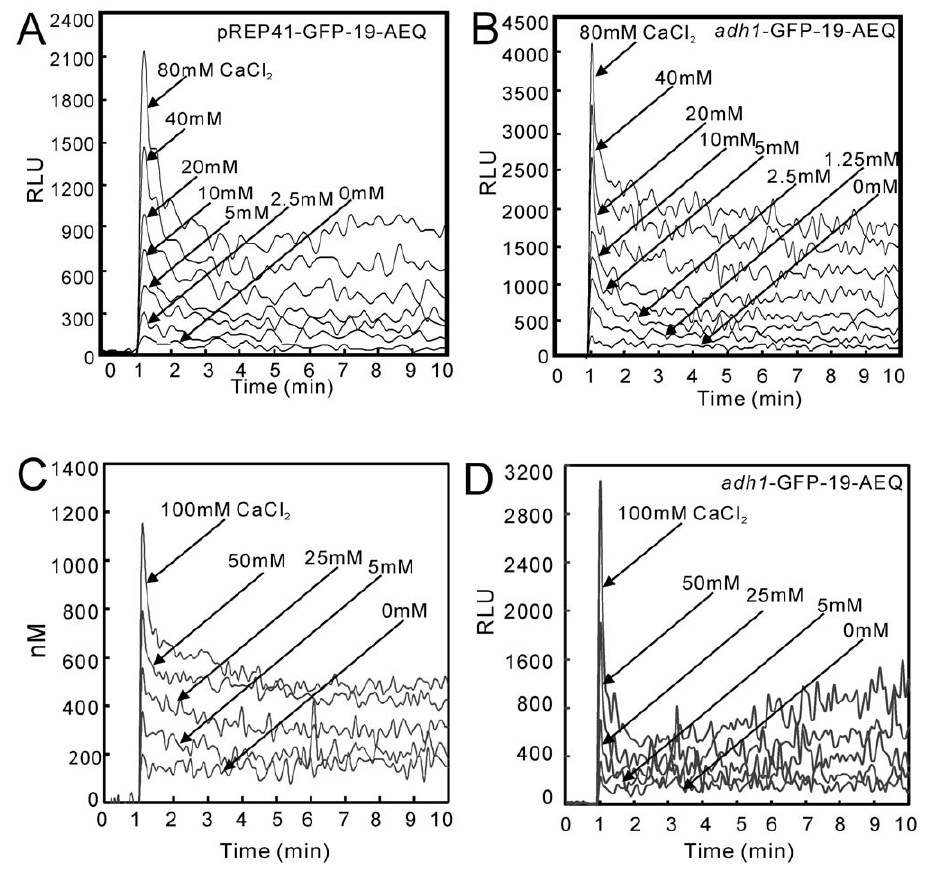
Figure 2. Real-time monitoring of the cytoplasmic Ca 2 + level using GFP-19-AEQ. Monitoring of the cytoplasmic Ca 2 + level using pREP41- GFP-19-AEQ (A) and adh1 -GFP-19-AEQ reporter vector (B). The wild-type cells were transformed with pREP41-GFP-19-AEQ (pKB6045) or adh1 -GFP-19- AEQ (pKB6892). The transformants were grown to exponential phase in the absence of thiamine for 36 hours to express apoaequorin. Then, the cells were collected and treated as described in Materials and Methods. A 10 m l volume of distilled water or 10 6 stock of various concentration of CaCl 2 were added into the 96-well plate, and the cells were delivered to the wells via the luminometer pump, and the luminescence was followed for 10 min. The aequorin luminescence, given as relative light units (RLU) s 2 1 , is plotted versus time. The data shown are representative of multiple experiments. (C) The molar concentration of the cytosolic Ca 2 + level in wild-type cells. The wild-type cells harboring reporter vector pKB6892 were cultured and assayed as described in Figure 2B. Then the quantification of cytoplasmic Ca 2 + concentration was performed as described in Materials and Methods. The data shown are representative of multiple experiments. (D) The burst-like peak seen in wild-type cells was similarly observed in the cam1-1 mutant cells. The cam1-1 mutant cells harboring reporter vector pKB6892 were cultured and assayed as described in Figure 2B. The data shown are representative of multiple experiments.